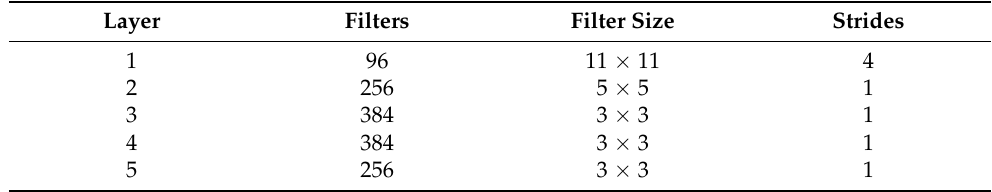
Table 1. AlexNet Architecture Convolution